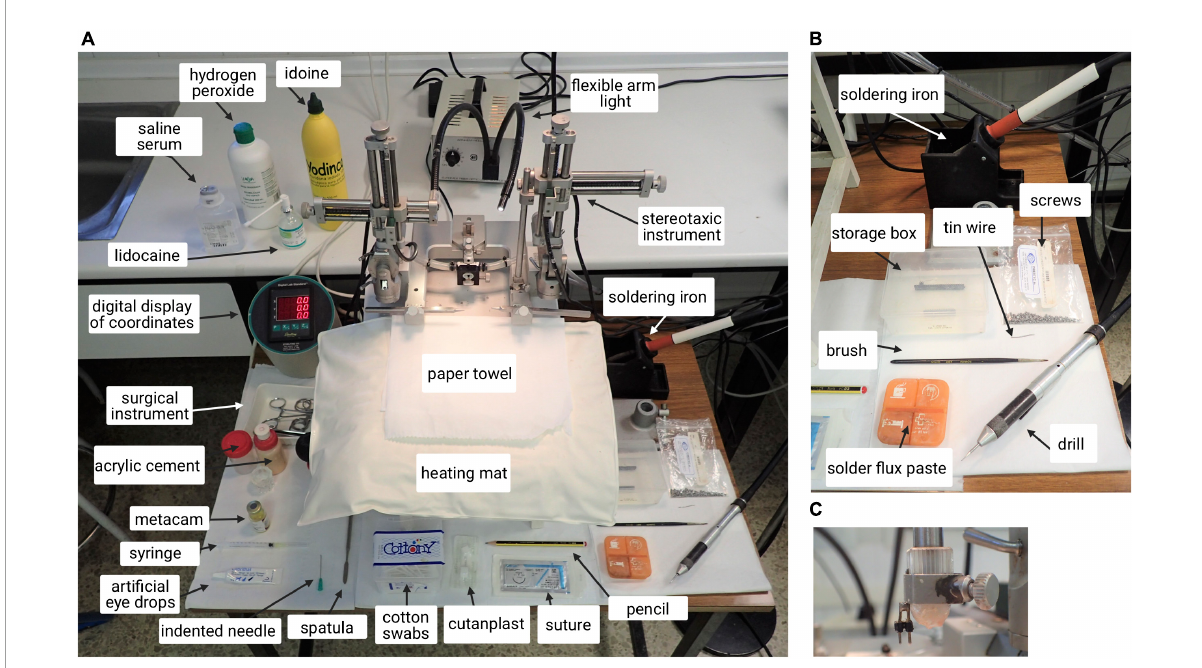
FIGURE2 Picture of equipment and surgery area. (A) Stereotaxic instrument with labeled materials. (B) Instruments and materials. (C) Magnification of the male pin attached to the stereotaxic arm. The female connector of the electrodes fabricated previously is attached to this male pin for support.